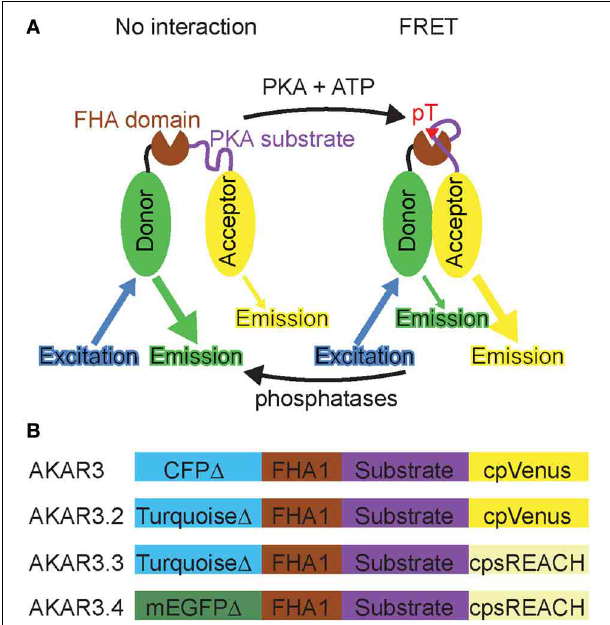
FIGURE 1 | Development of a PKA sensor compatible with 2-photon Fluorescence Lifetime Imaging Microscopy (2pFLIM). (A) Diagram illustrating how PKA activity induces FRET in the reporter. Upon phosophrylation by PKA, the substrate region binds FHA domain, bringing the donor and acceptor together and resulting in FRET. The phosphorylated reporter leads to an increase of acceptor:donor emission ratio, as well as a decrease in donor fluorescence lifetime because of an additional energy transfer pathway. (B) Schematic of the original PKA reporter AKAR3 (Allen and Zhang, 2006) and three new PKA